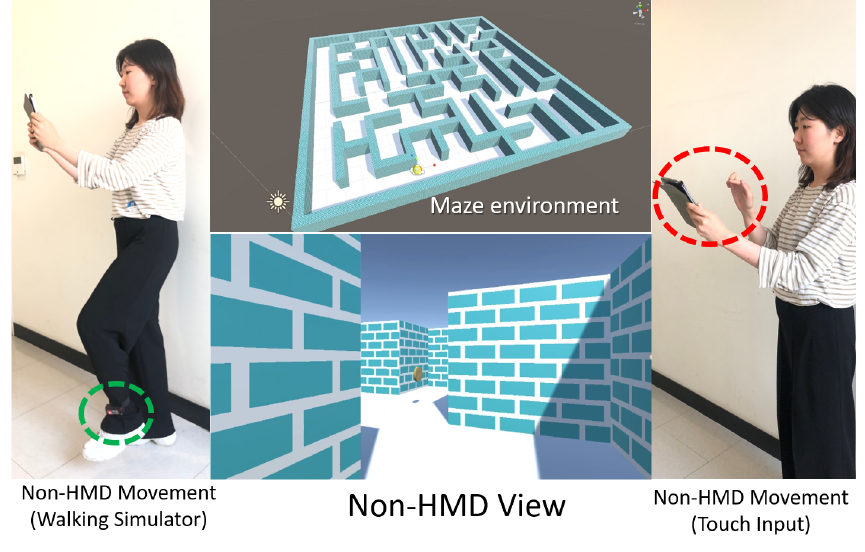
Figure 6. Experimental environment for non-HMD user movement using a walking simulator and touch